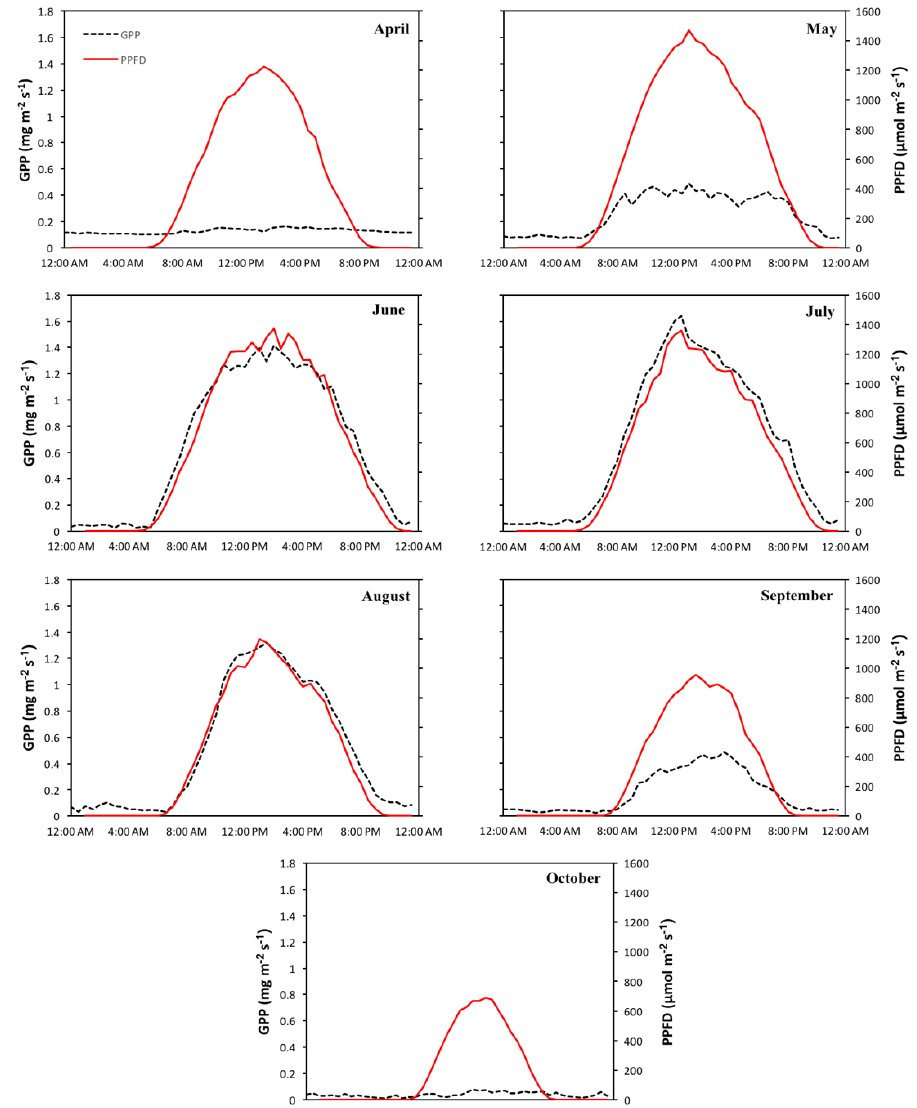
Figure 5. Mean diurnal monthly pattern of gross primary productivity (GPP) (black dotted line) and photosynthetic photon flux density (red line) for the growing season (April–October).